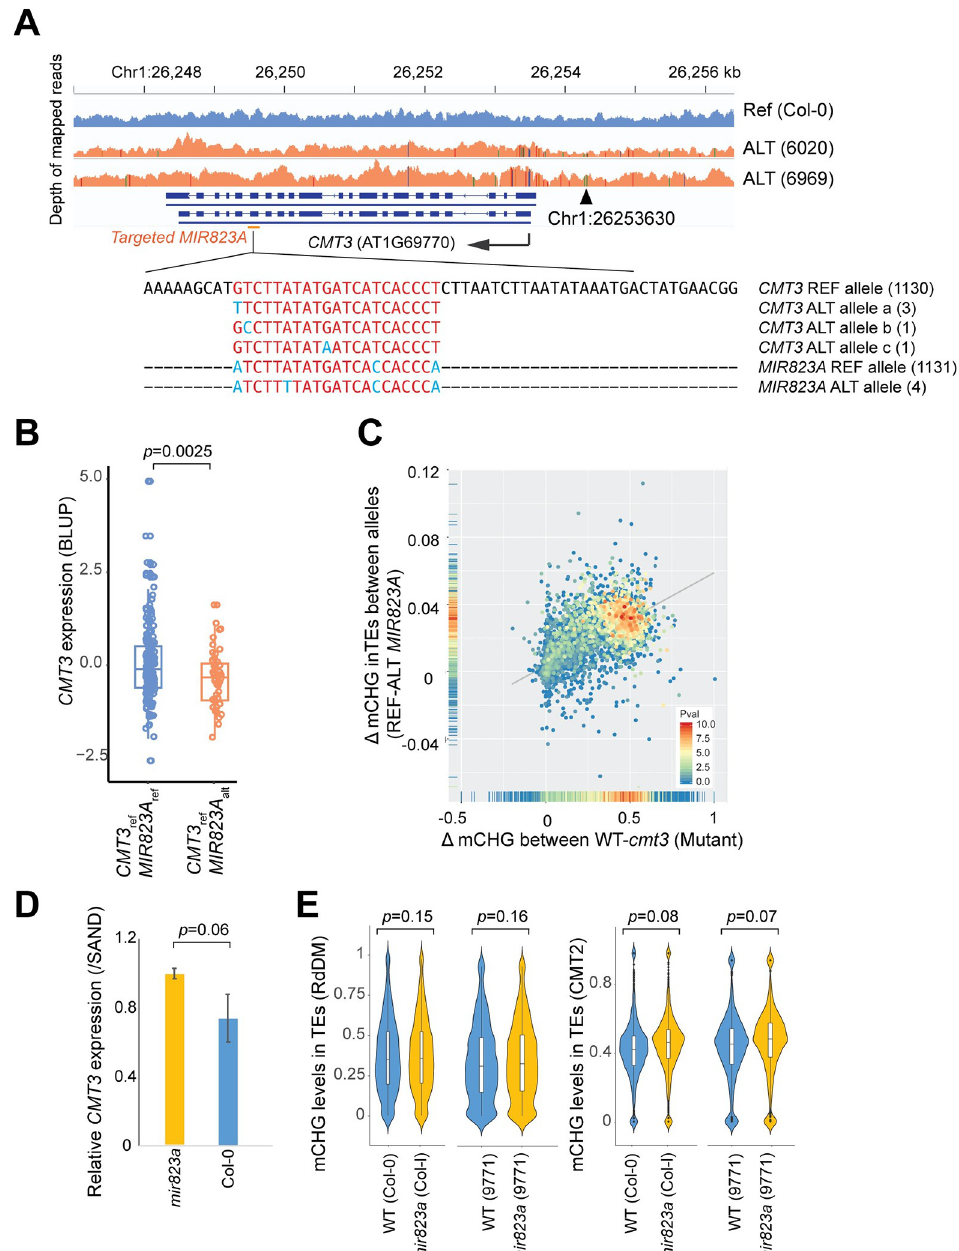
Fig 4. Effects of MIR823A on mCHG levels. (A) Polymorphisms in the miRNA region of MIR823A and the target in CMT3 in 1135 natural lines. Differences from the CMT3 reference sequence are shown in light blue. Haplotype counts are shown in parentheses. (B) Estimated effects of MIR823A alleles on CMT3 expression in natural lines with individual values (Welch’s t-test, two-tailed, CMT3 expression was collected from transcriptome data published in [20]). (C) Scatter plot comparing the average allelic effect of the MIR823A polymorphism with the effect of cmt3 in the Col-0 background. Dots represent individual transposons, and the colors show the significance of the allelic effects as -log 10 p-value in GWAS. (D) CMT3 expression in early embryos with standard errors in WT (Col-0) and mir823a . Significance of the difference in mean tested using Welch’s t-test ( n = 3, one-tailed). (E) The distribution of mCHG levels in RdDM and CMT2-targeted transposons, comparing knock-outs of MIR823A to wild-type in different backgrounds.